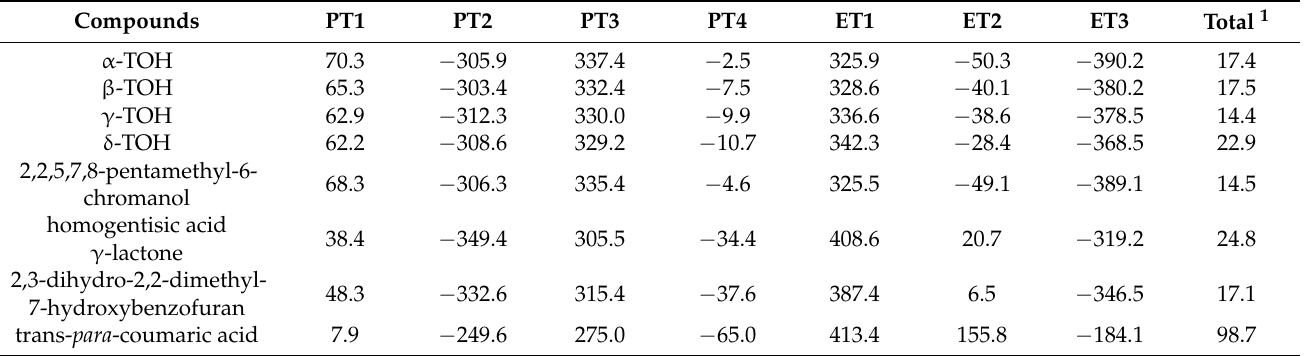
Table 1. Δ G ° values (kJ mol −1 , 298.15 K) for PCET between O 2 •− and TOH, and the related com- Table 1. ∆ G ◦ values (kJ mol − 1 , 298.15 K) for PCET between O 2 •− and TOH, and the related